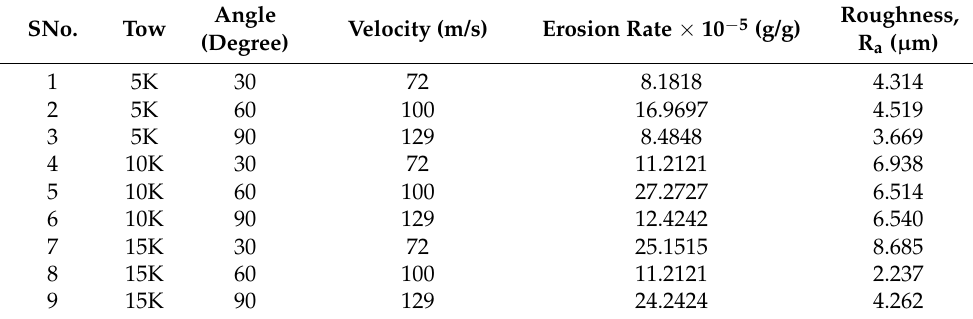
Table 4. Experimental